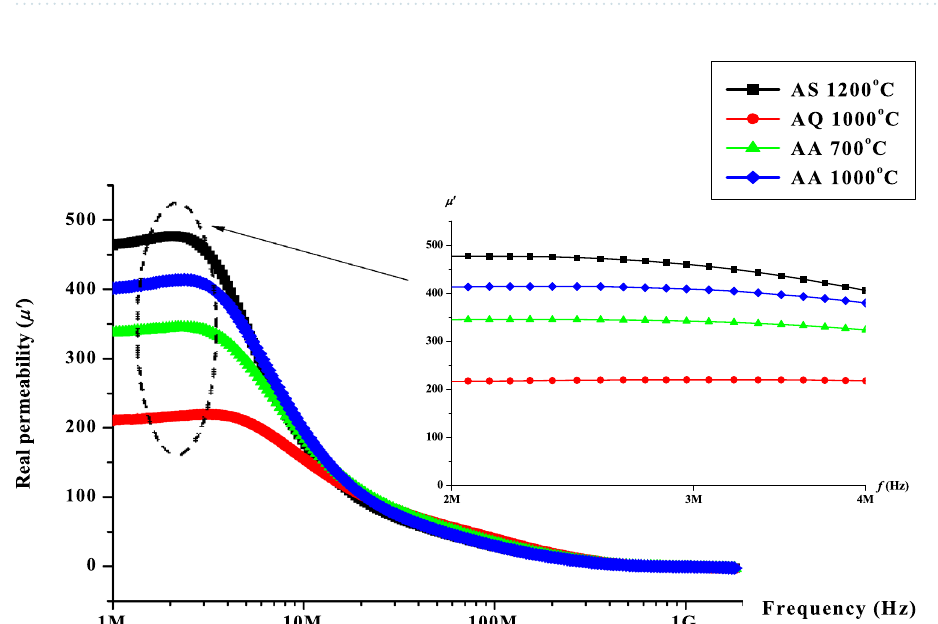
Figure 5. Graph of real permeability, µ ′ versus frequency after sintering at 1200 °C, after quenching at 1000 °C, after annealing at 700 and 1000